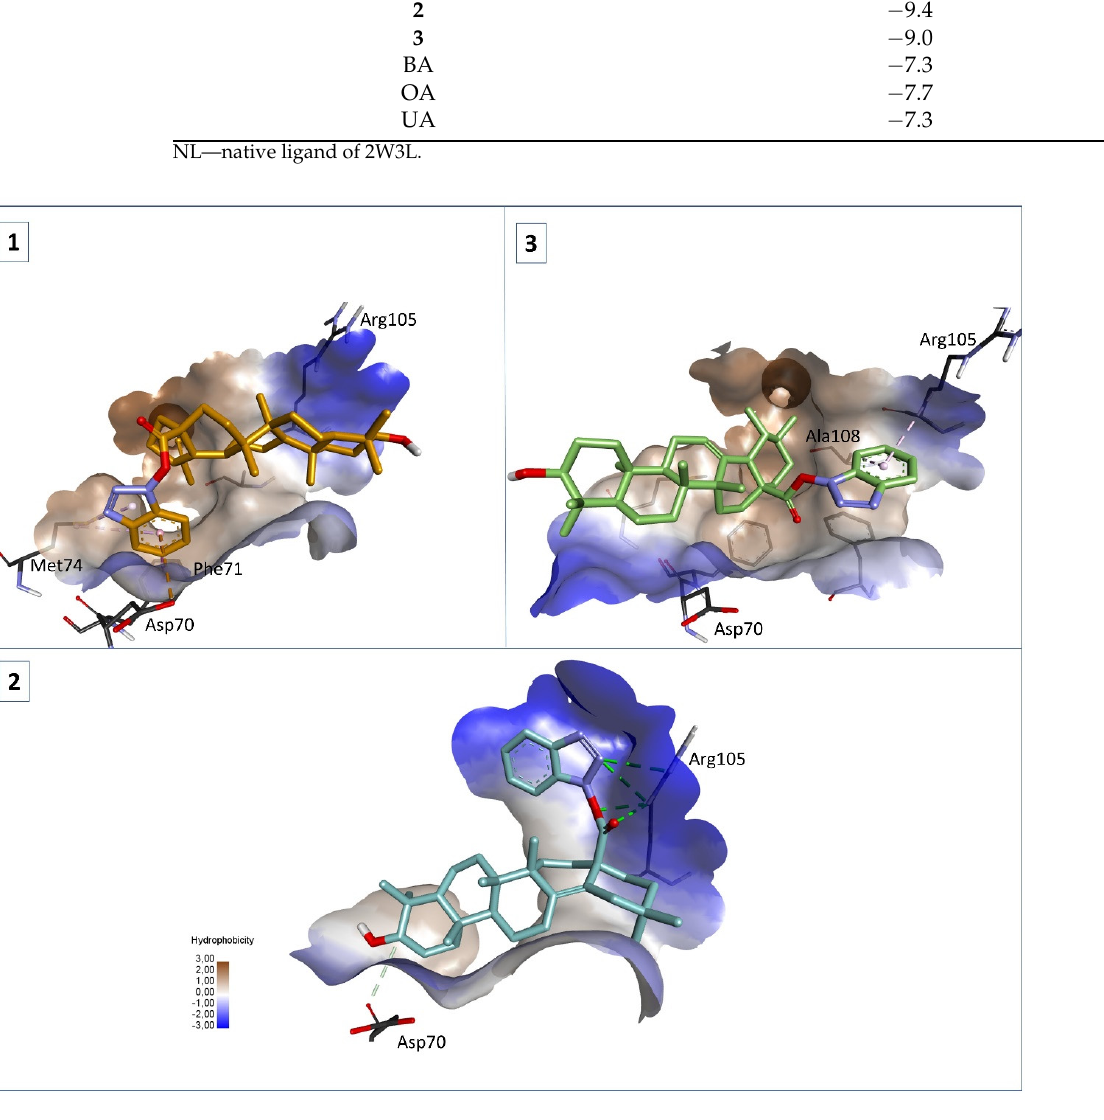
Figure 11. Structure of Bcl-2 (2W3L) in complex with compounds 1 (orange), 2 (blue), and 3 (green); HB interactions are depicted as green dotted lines, hydrophobic interactions as purple dotted lines, and electrostatic interactions as orange dotted lines; interacting amino acids are shown as dark gray sticks.